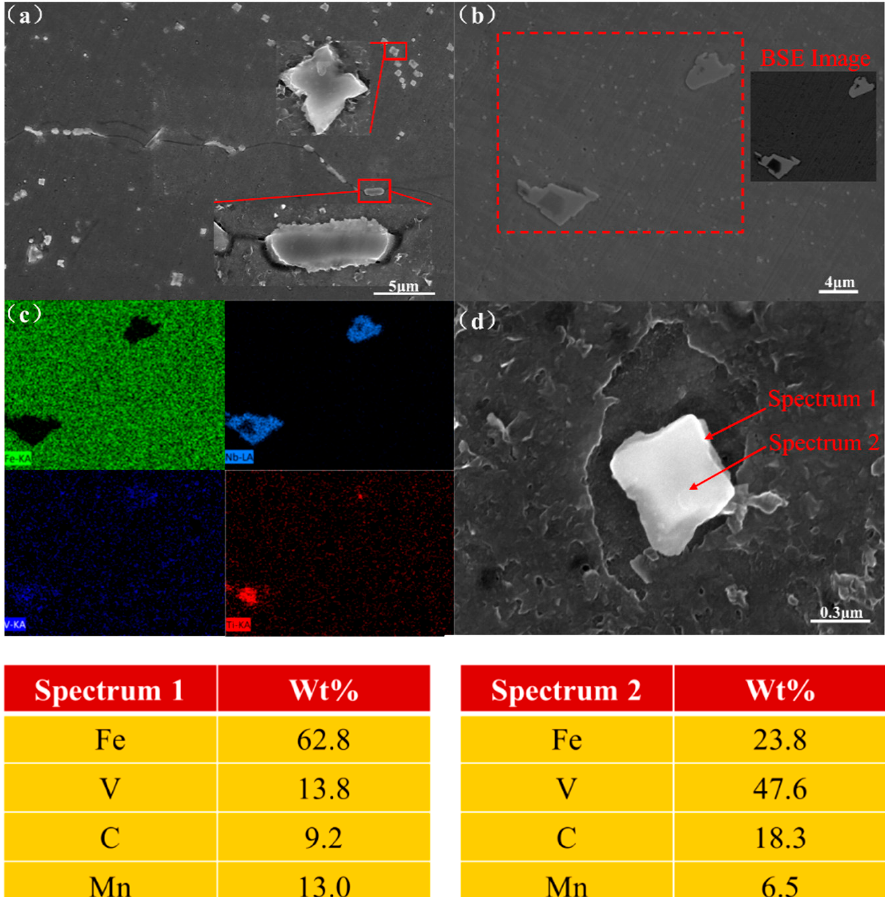
Figure 10. Grain size analysis of CHP and SHPP steel by orientation decomposition image map ( a ); FESEM micrographs of distribution and quantity of precipitates in both steels ( b ); size distribution of austenite grain in both steels ( c ).